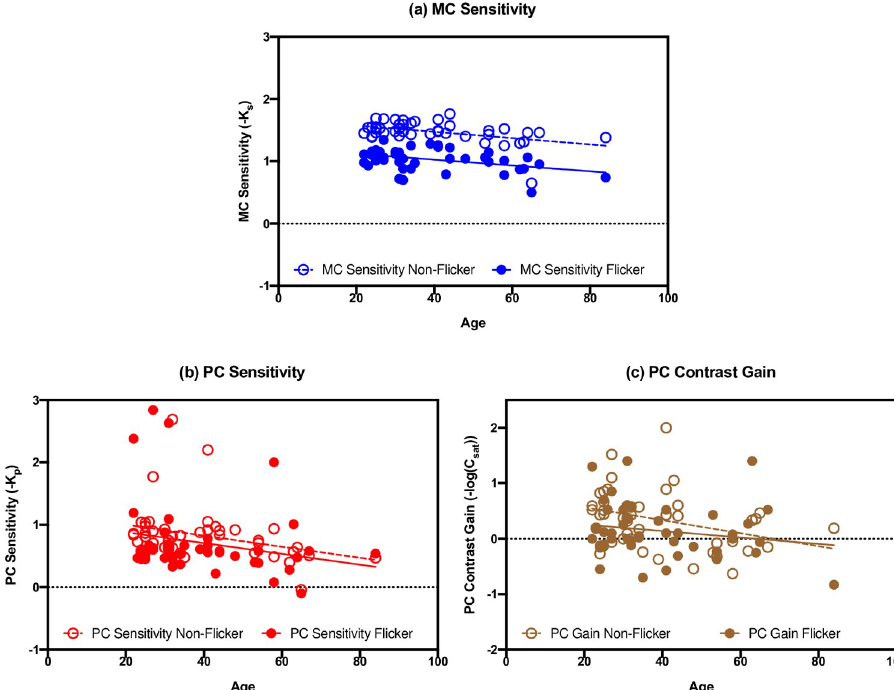
Fig 3. The best fitting parameters for all observers with the effects of age and flicker adaptation: (a) parameter data for MC contrast sensitivity (- K s ), (b) parameter data for PC contrast sensitivity (- K gain (- log ( C sat )). Open circles represent the data from the non-flicker adaptation condition, while filled circles represent the data from the flicker adaptation condition.